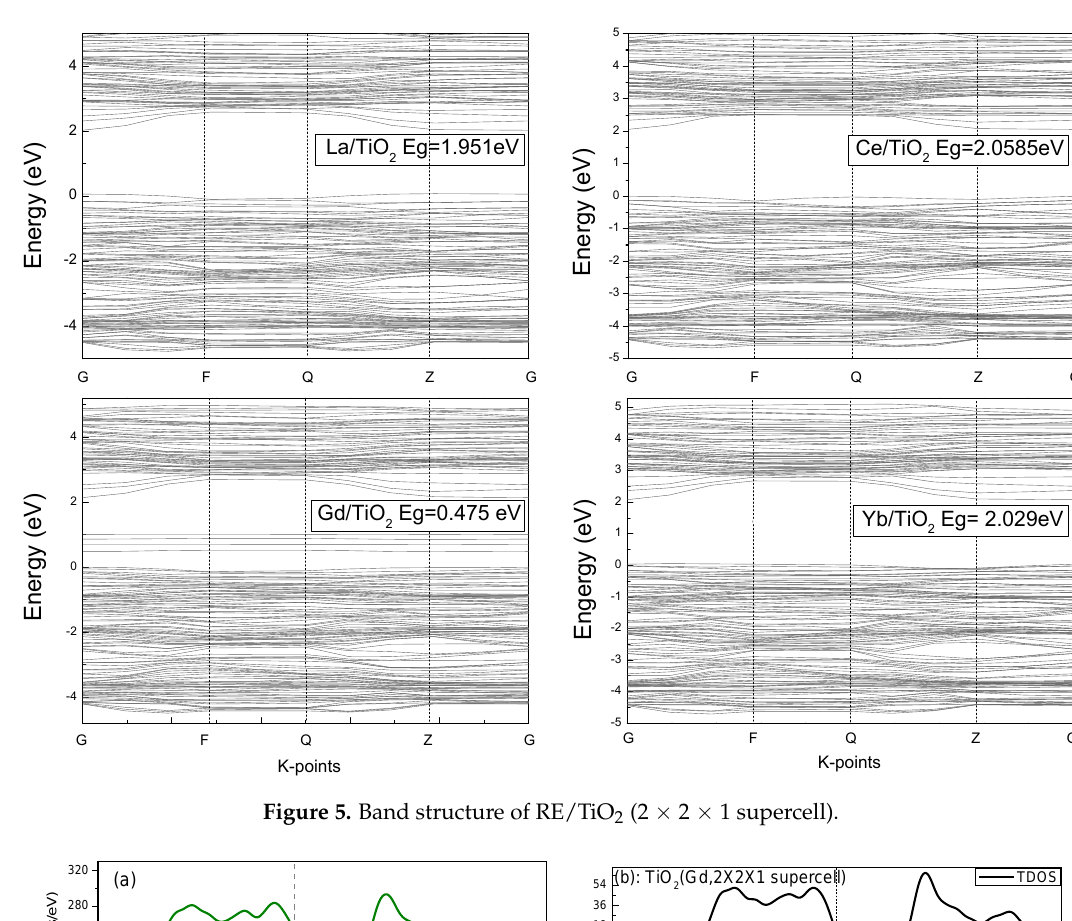
Figure 5. Band structure of RE/TiO 2 (2 × 2 × 1 supercell).